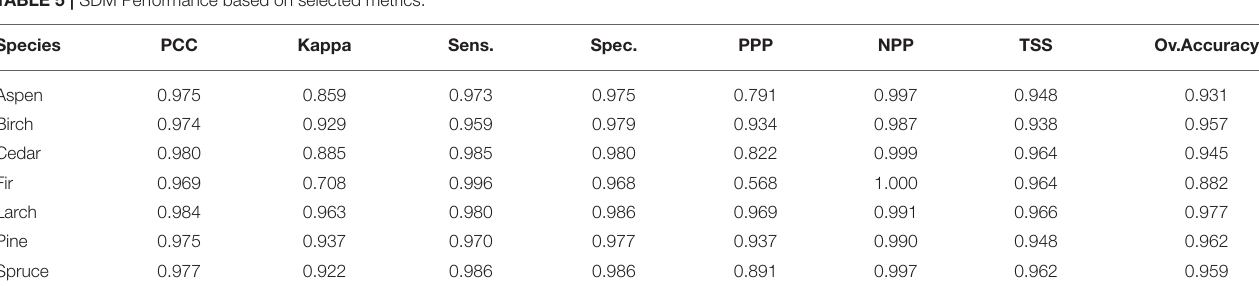
TABLE 5 | SDM Performance based on selected metrics. Species PCC Kappa Sens. Spec. PPP NPP TSS